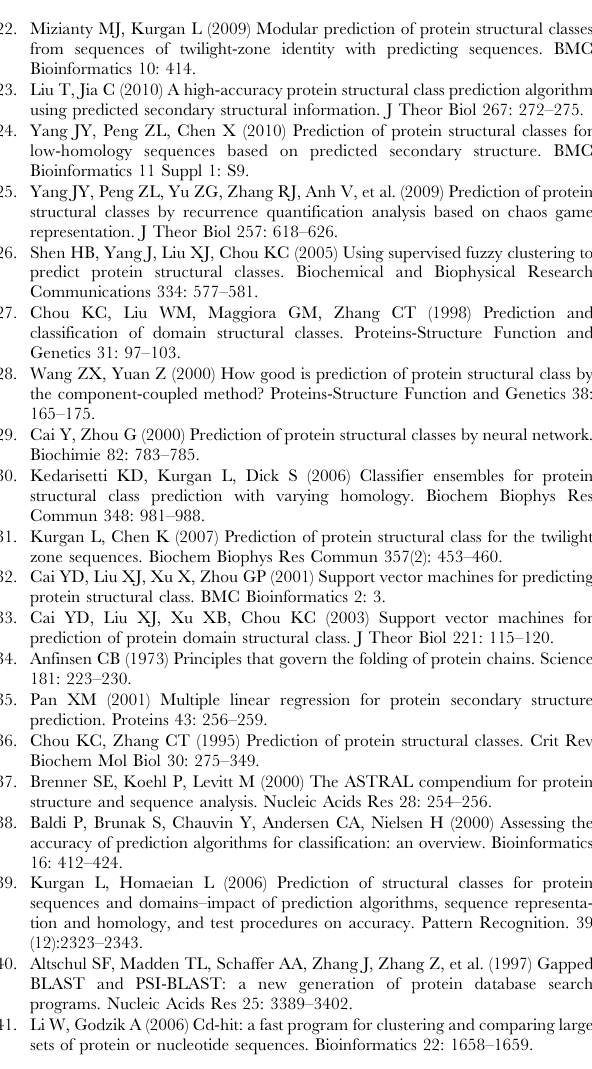
Table S1 List of the D8244 dataset. Table S2 List of the D1185